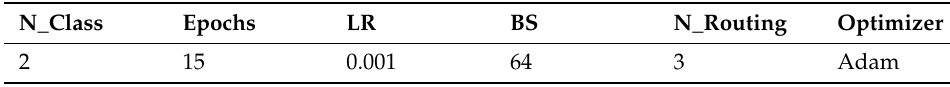
Table 2. Training Parameters for CapsNetCovid.